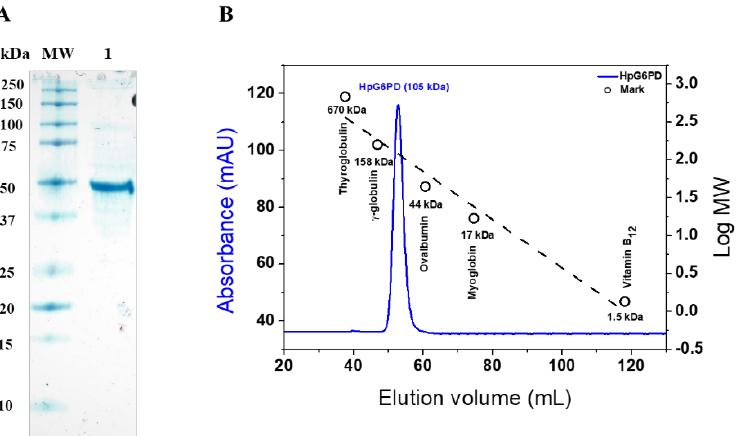
Figure 2. Purification and molecular exclusion chromatogram of the recombinant HpG6PD enzyme. ( A ) SDS-PAGE analysis of the recombinantly produced HpG6PD. The protein was analyzed on 12% polyacrylamide gel electrophoresis (SDS-PAGE). M: Bio-Rad kaleidoscope MW marker. Lane 1: 20 micrograms of purified HpG6PD protein. The gels are representative of three independent experiments. ( B ) FPLC chromatogram of native HpG6PD and standard proteins (black dashed line, Bio-Rad), as follows: bovine thyroglobulin, 670 kDa; bovine γ -globulin, 158 kDa; ovalbumin, 44 kDa; horse myoglobin, 17 kDa; and vitamin B12, 1.3 kDa.